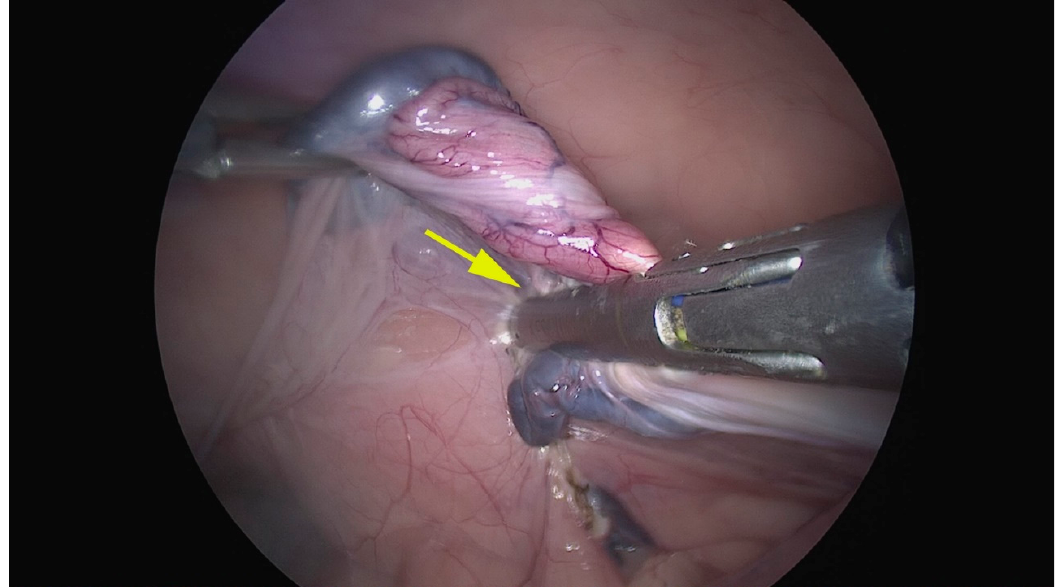
Figure 4. Representative image of right ovariectomy performed by the Caiman 12. The yellow arrow shows that the entire tissue was completely included between the